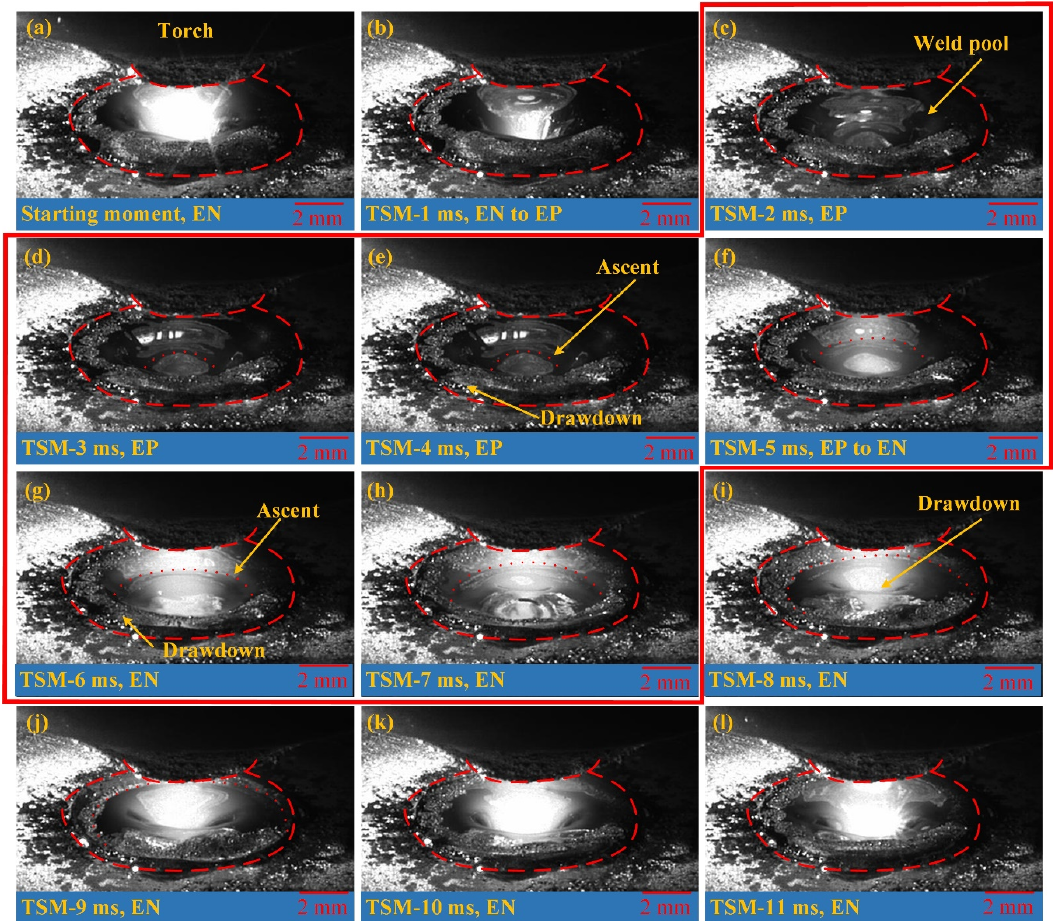
Figure 7. The evolution of weld pool free surface in one current cycle. ( a ) Starting moment (EN); ( b ) TSM-1 ms (EN to EP); ( c ) TSM-2 ms (EP); ( d ) TSM-3 ms (EP); ( e ) TSM-4 ms (EP); ( f ) TSM-5 ms (EP to EN); ( g ) TSM-61 ms (EN); ( h ) TSM-7 ms (EN); ( i ) TSM-8 ms (EN); ( j ) TSM-9 ms (EN); ( k ) TSM-10 ms (EN); ( l ) TSM-11 ms